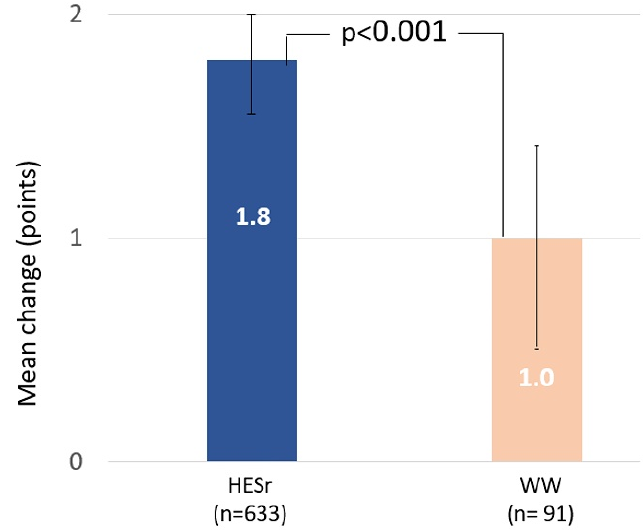
Figure 3. Mean (95% CI) improvement in BII total score from baseline to 6 months for the HESr and WW groups. HESr: hexanic extract of Serenoa repens ; WW: watchful waiting; BII: Benign Prostatic Hyperplasia Impact Index.